Question: Express in one sentence what the figure is showing.
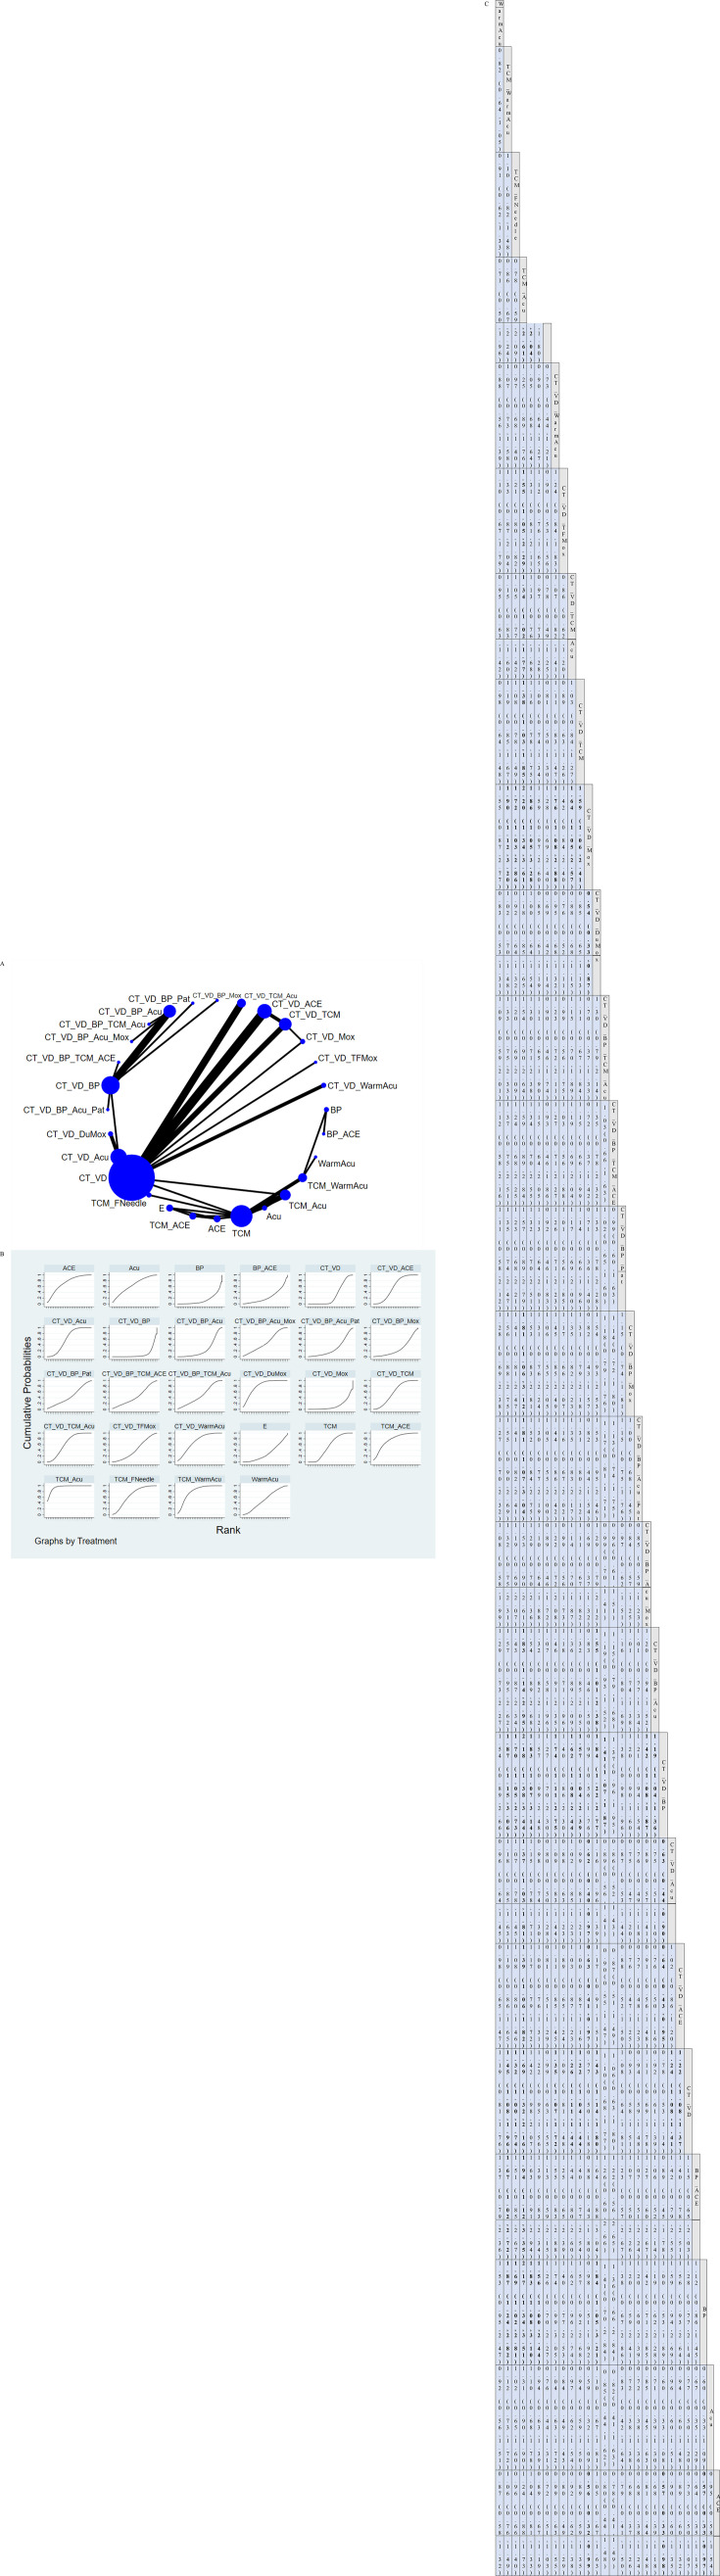
Answer: Network meta-analysis of clinical efficacy. (A) Network plot of the network meta-analysis for clinical efficacy. (B) Rankogram of overall intervention strategies from the network meta-analysis for clinical efficacy. (C) League table of the network meta-analysis for clinical efficacy.